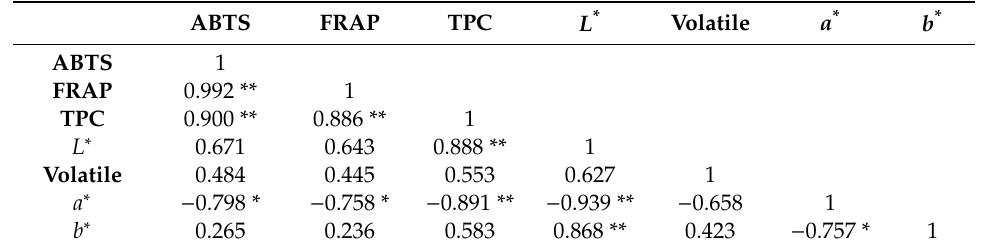
Table 6. Pearson correlation